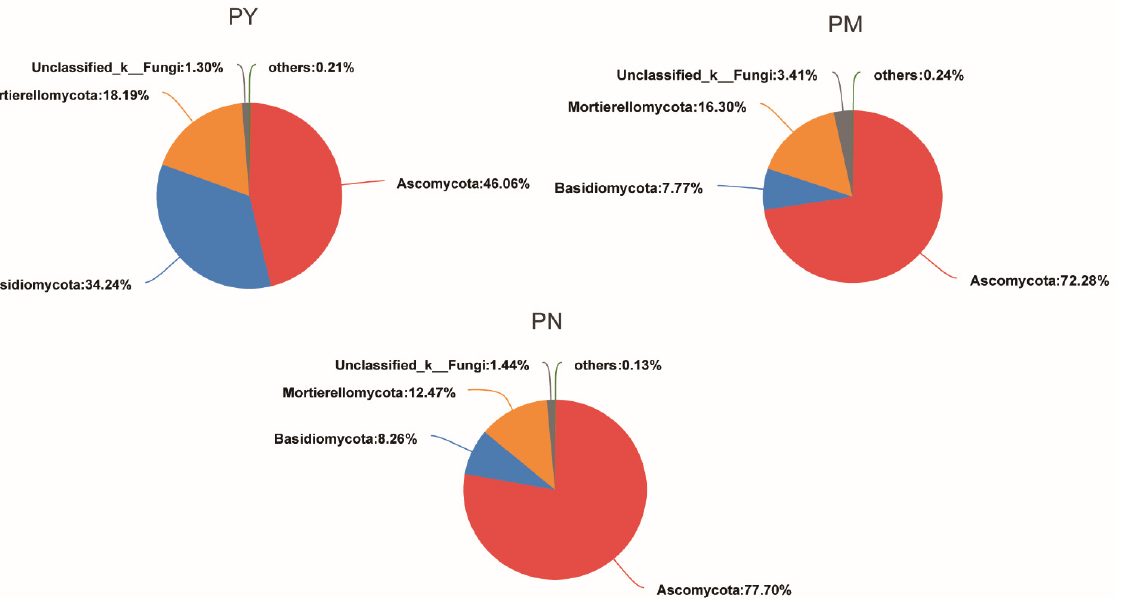
Commented [M1]: The sum of the percentages is not equal to 100%, please revise it. Please carefully check all the similar issues.